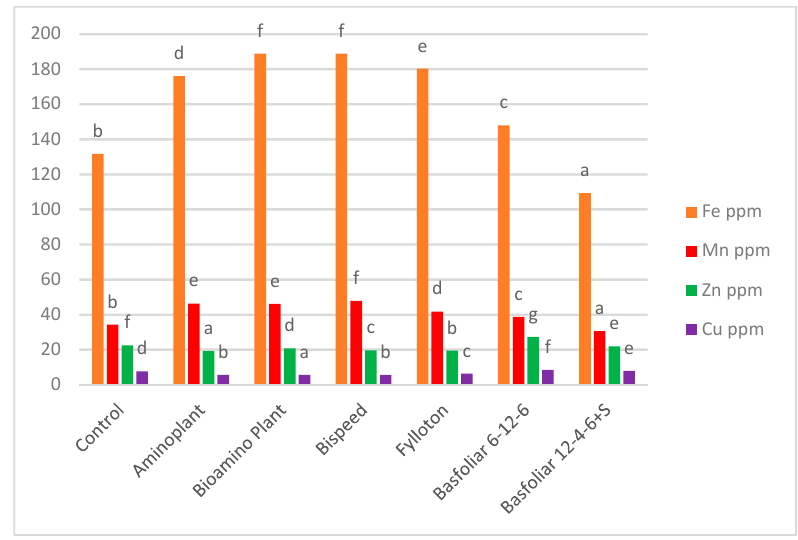
Figure 3. A comparison of the contents of micronutrients in the leaves of maiden apple trees depending on the applied foliar treatment. Data followed by the same letters do not differ significantly at p = 0.05 for each micronutrient according to Tukey’s test.